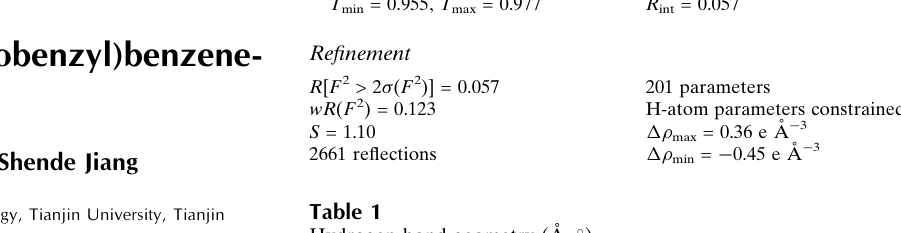
Rigaku Saturn diffractometer Absorption correction: